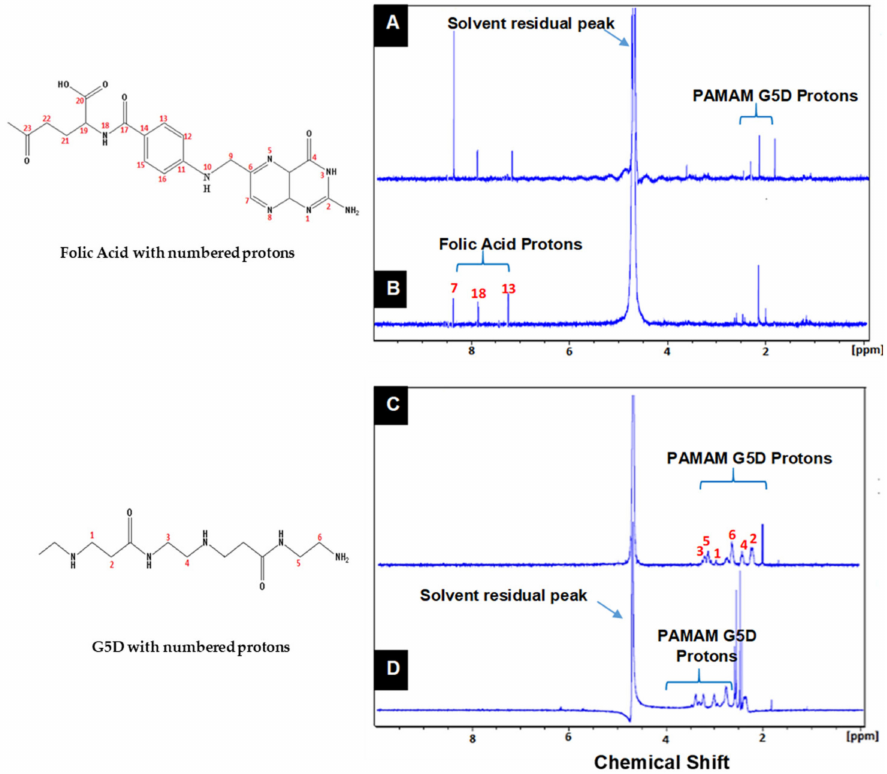
Figure 2. The 1 H NMR spectra of PAMAM dendrimer (G5D) and folic acid-functionalized gold nanoparticles in D 2 O. ( A ) G5D:FA, ( B ) Au:G5D:FA, ( C ) G5D, ( D )